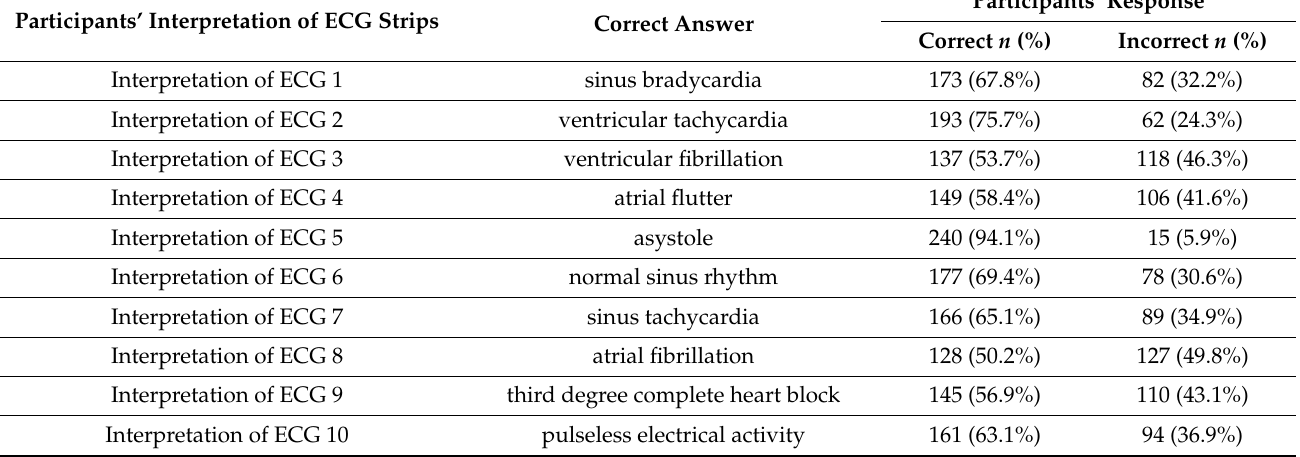
Table 3. Distribution by percentage of nurses’ ECG interpretation